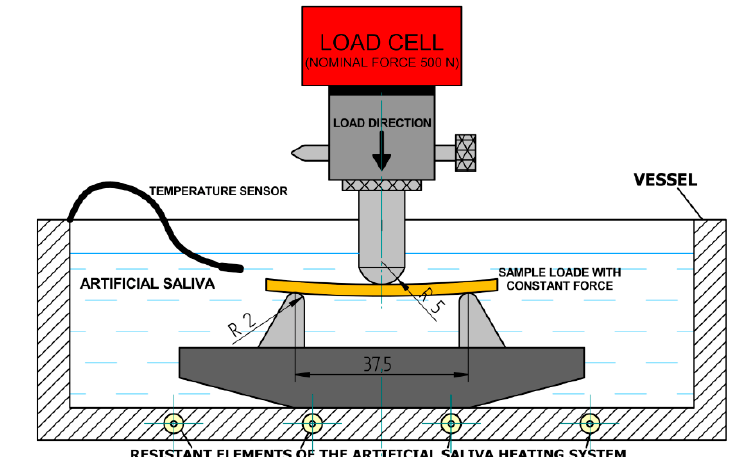
Figure 5. Diagram of the creep test.